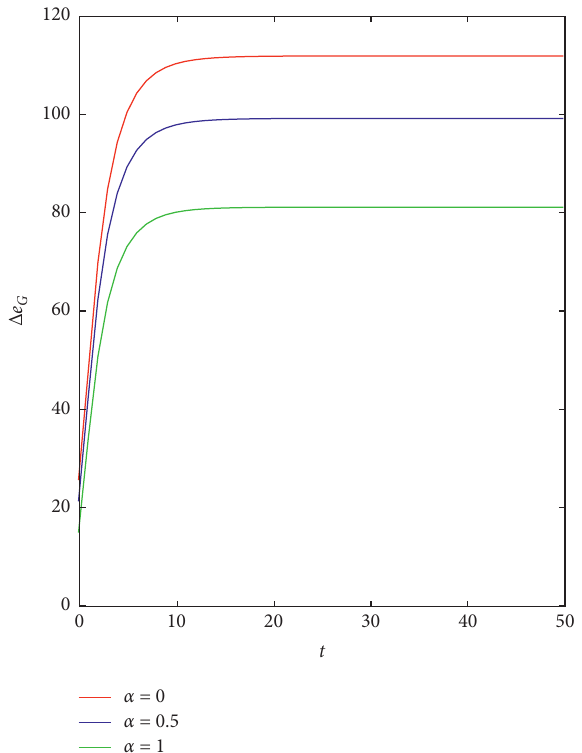
Figure 7: Trajectories of Δ e